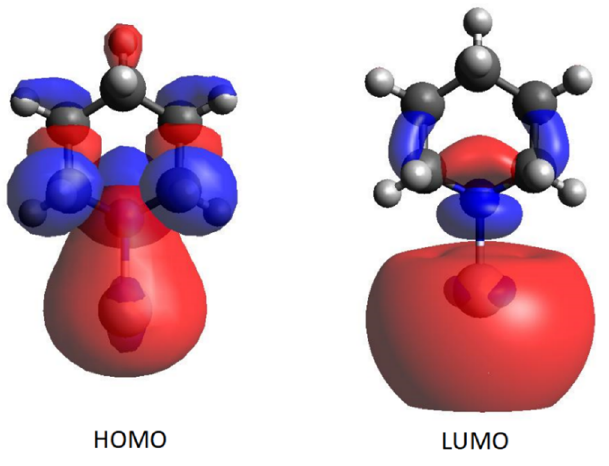
Figure 7. Calculated HOMO and LUMO orbitals of the Anion-Ag + equatorial complex.